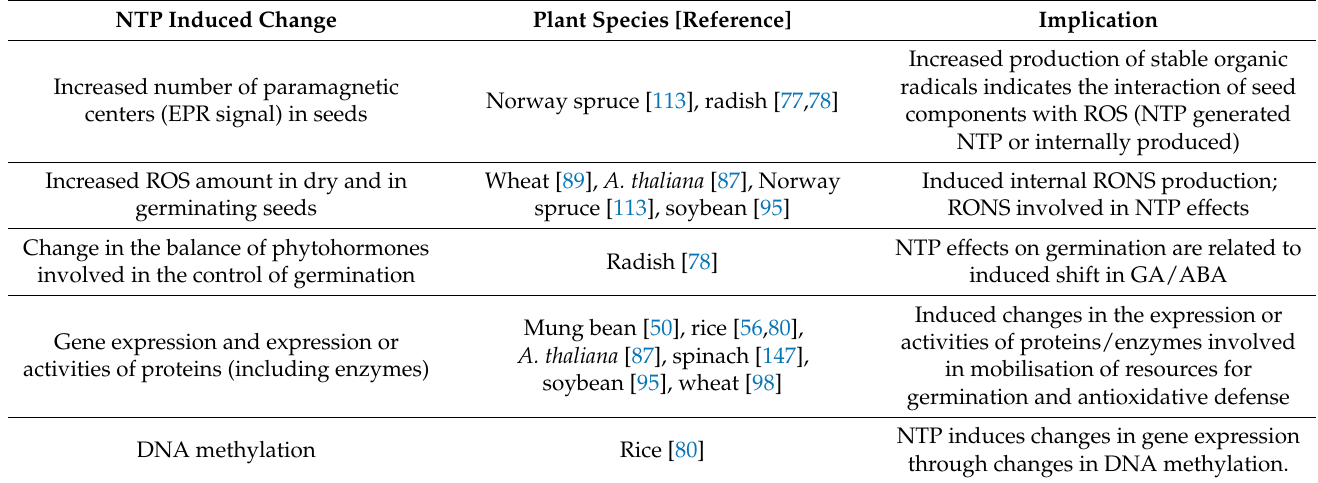
Table 3. Summary of the published findings on NTP-induced changes in biochemical processes in dry